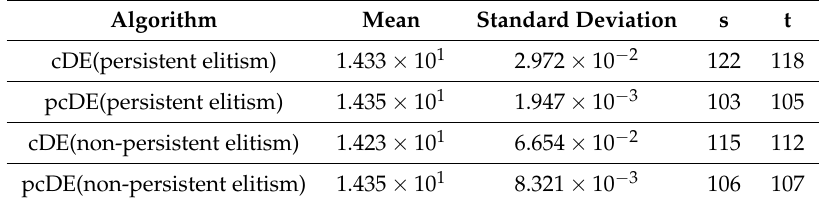
Table 4. Final fitness and standard deviation of the Lena images tested with four algorithms.